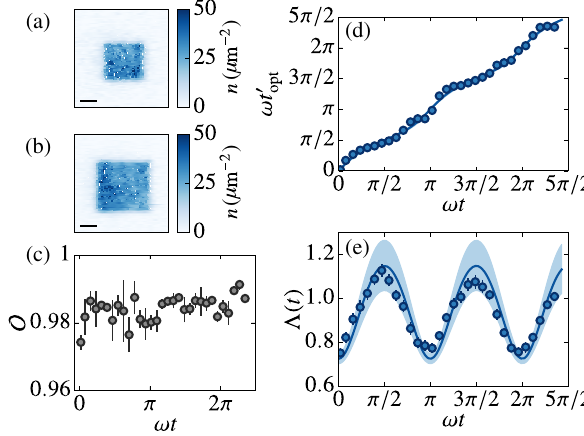
FIG. 3. Scaling factor at ω t ¼ π = 2 for different values of ˜ gN . (a) Initial density distribution of the cloud. (b) – (d) Density distributions of the cloud after an evolution during t ¼ π = ð 2 ω Þ in the harmonic trap for different values of ˜ gN . For (a) – (d), the horizontal black lines represent 10 μ m. Main graph: Best scaling factor Λ − 2 as a function of ˜ gN . The red square corresponds to the reference image and its ordinate is fixed to 1. The solid line represents the prediction (26). The shaded area represents its uncertainty due to the one in the atom number of the reference point. The vertical error bars represent the precision at 2 standard deviations of the fit that determines Λ − 2 . (e) Value of the overlap between the density distributions and the reference point. The error bars due to the fit are smaller than the black points.